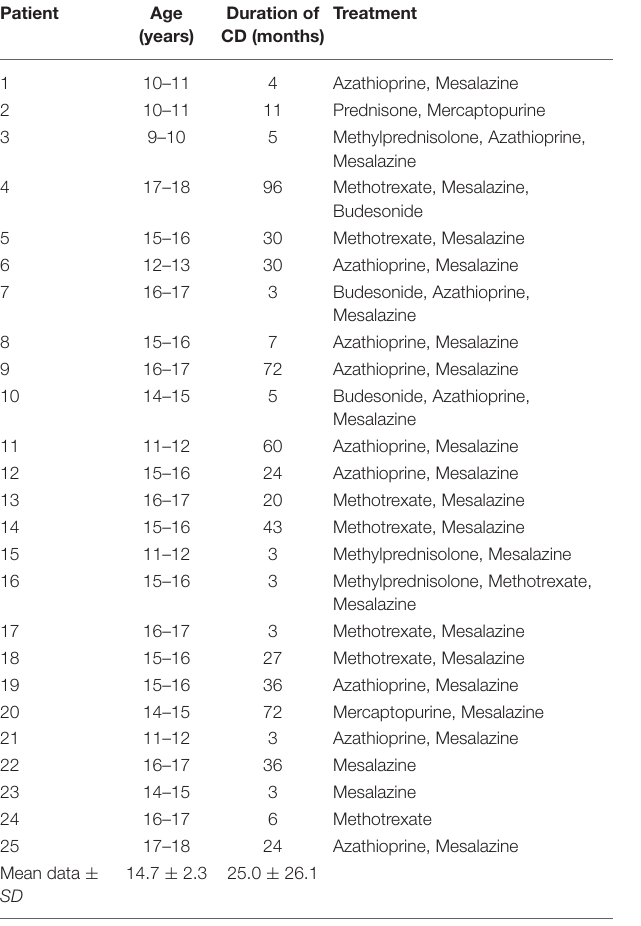
TABLE 2 | The detailed characteristic of the control group—patients not treated with anti-TNF therapy.